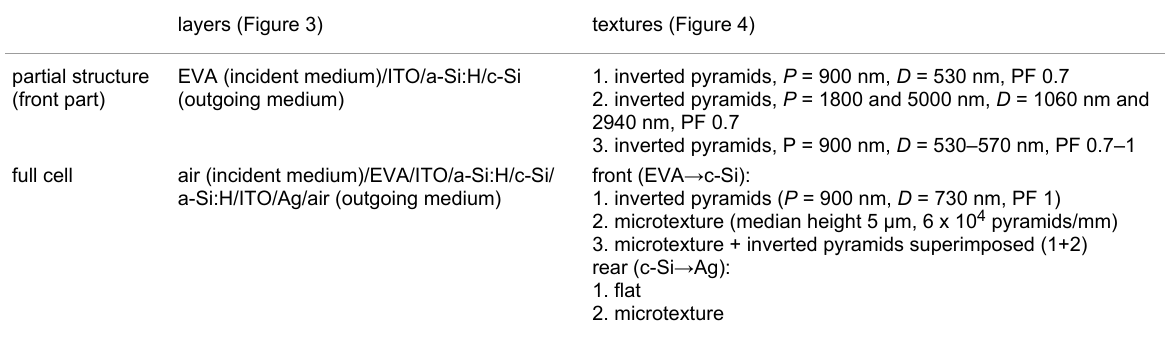
Table 1: Analyzed structures. layers (Figure 3) textures (Figure 4) partial structure (front